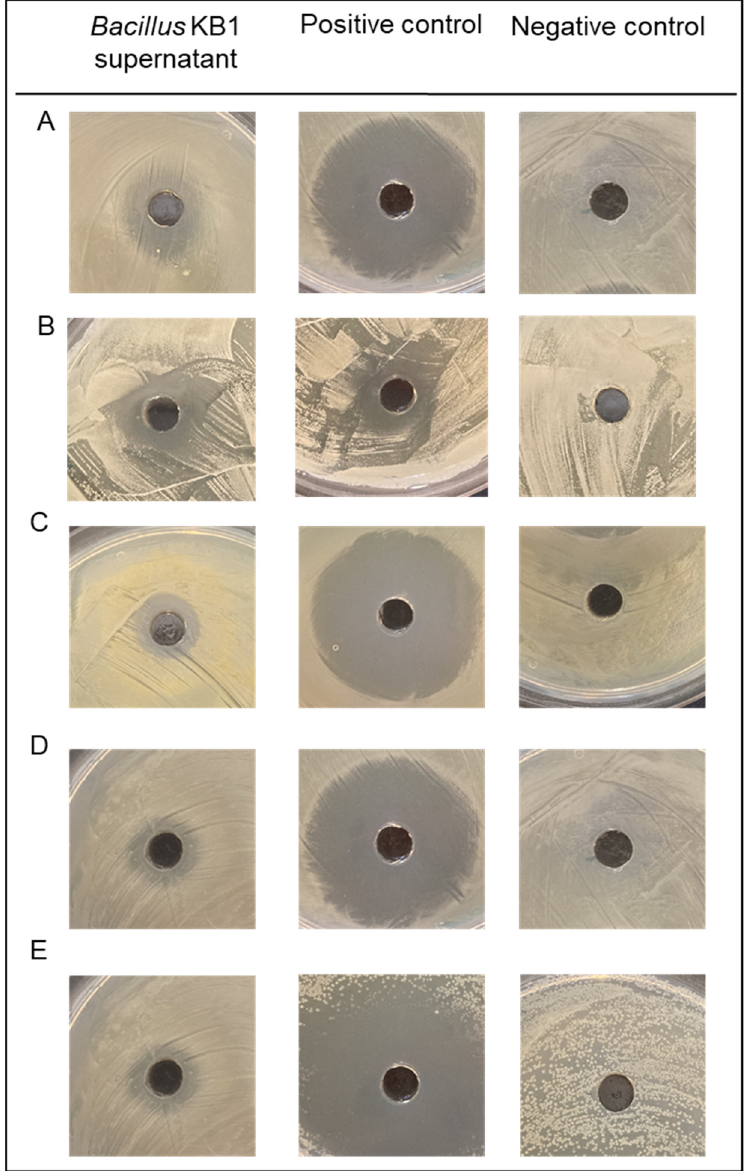
Figure 2. Antimicrobial activity of Bacillus fermented supernatant against bacterial and yeast pathogens; ( A ) P. aeruginosa , ( B ) C. albicans , ( C ) S. aureus , ( D ) E. coli , ( E ) S. epidermidis . Table 1. Influence of Bacillus -fermented supernatant on selected pathogenic strains – inhibition zone, MIC value, biofilm formation and adhesion to the polystyrene surface.